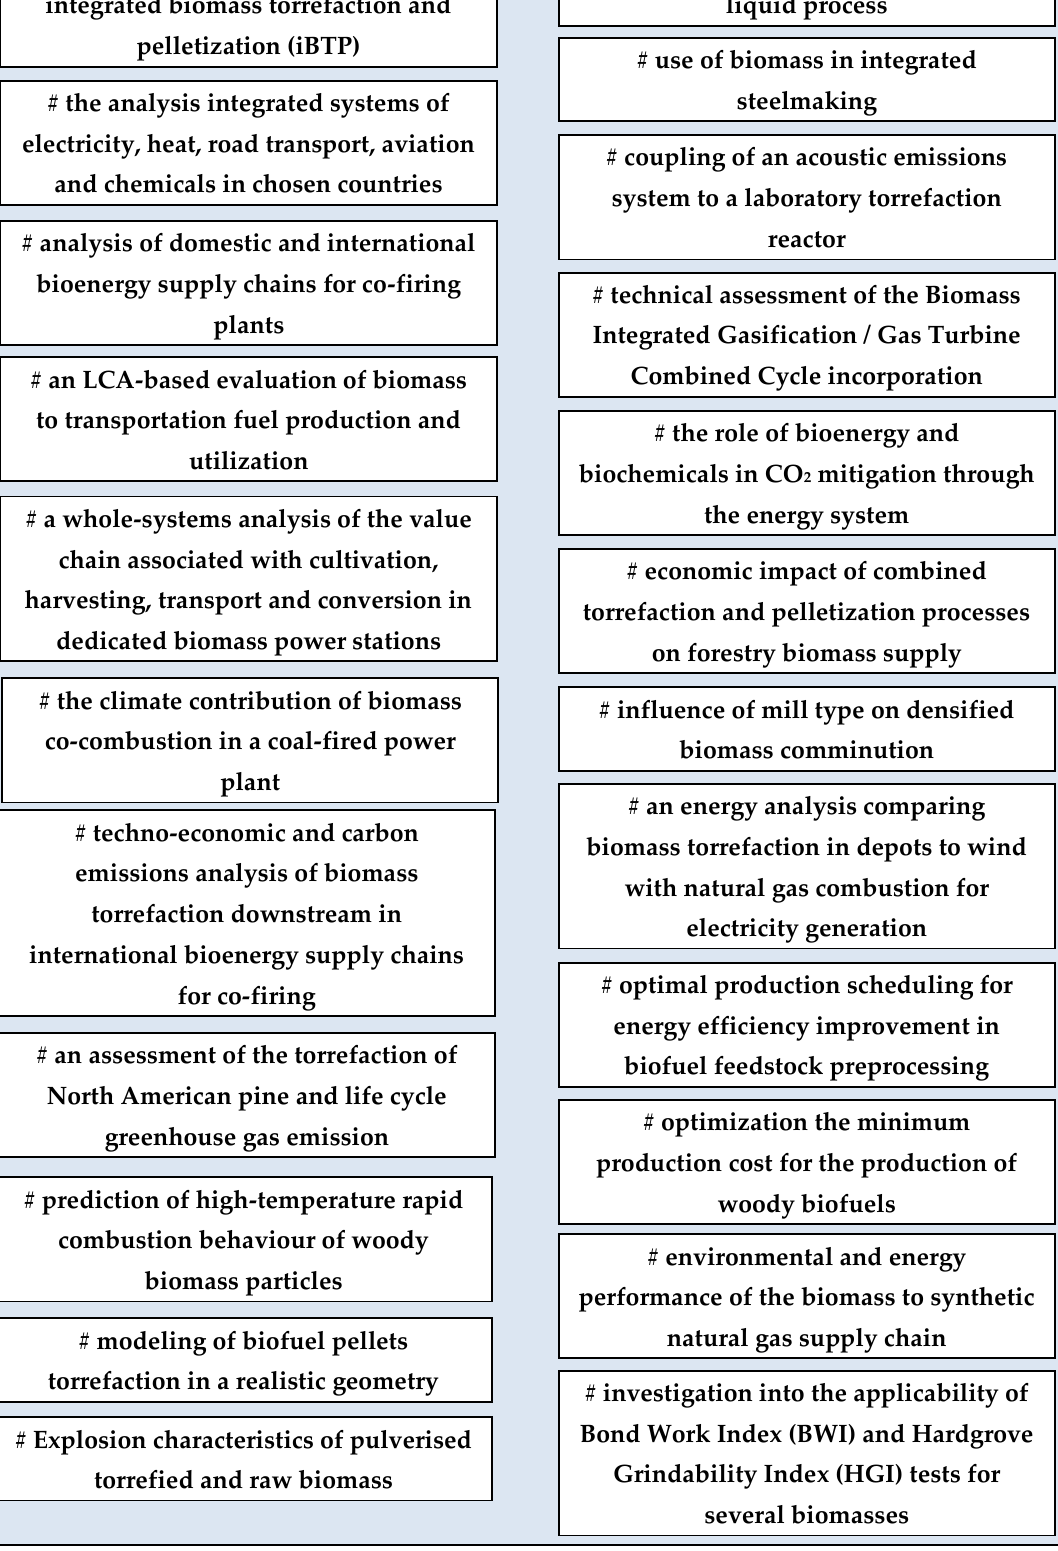
Figure 14. Main research topics — other topics.